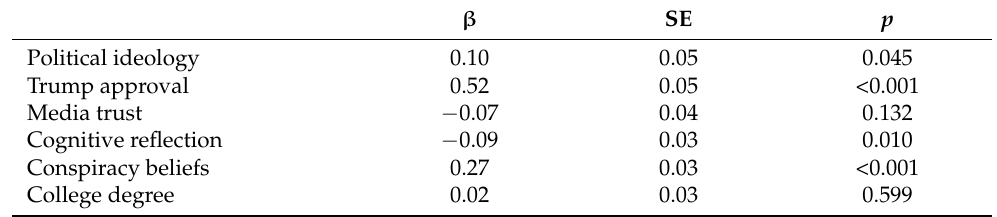
Table 2. Standardized regression coefficients for the associations with belief in false election